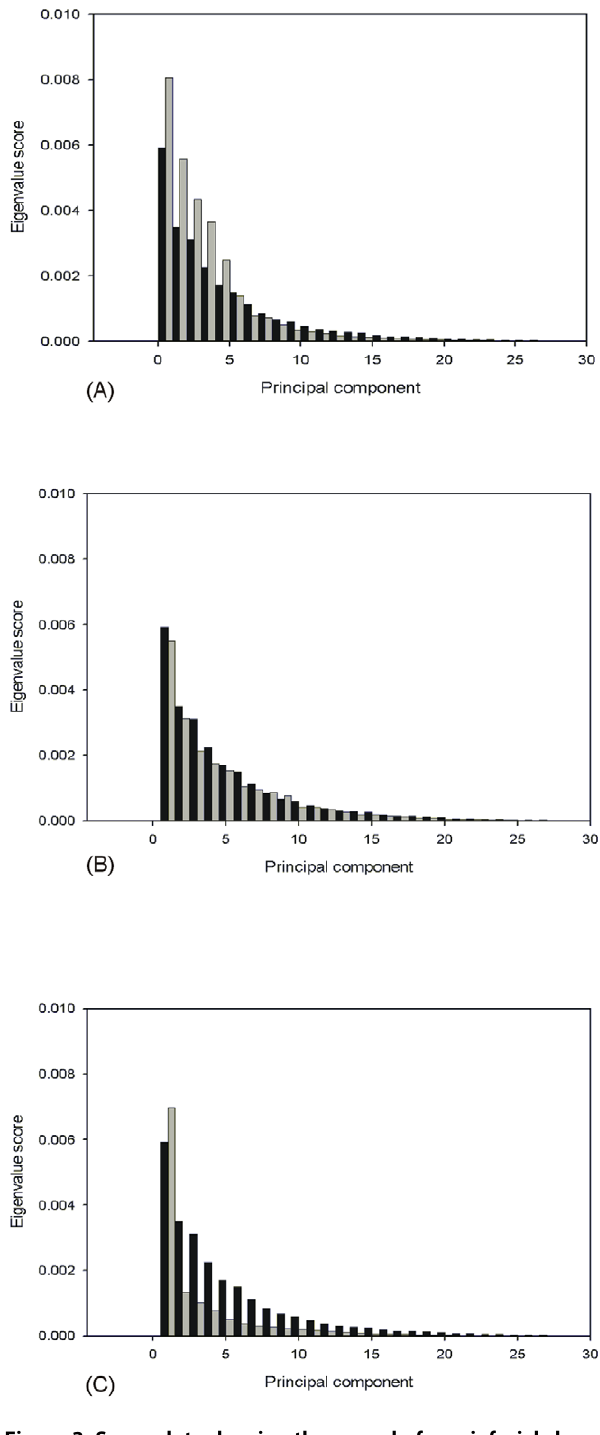
Figure 3. Scree plots showing the spread of craniofacial shape variation across the eigenvalues for the common morphspace (black bars repeated in each plot) and each of the African rift lake cichlid assemblages (grey bars). Tanganyika is represented in (A), Malawi in (B) and Victoria in (C).